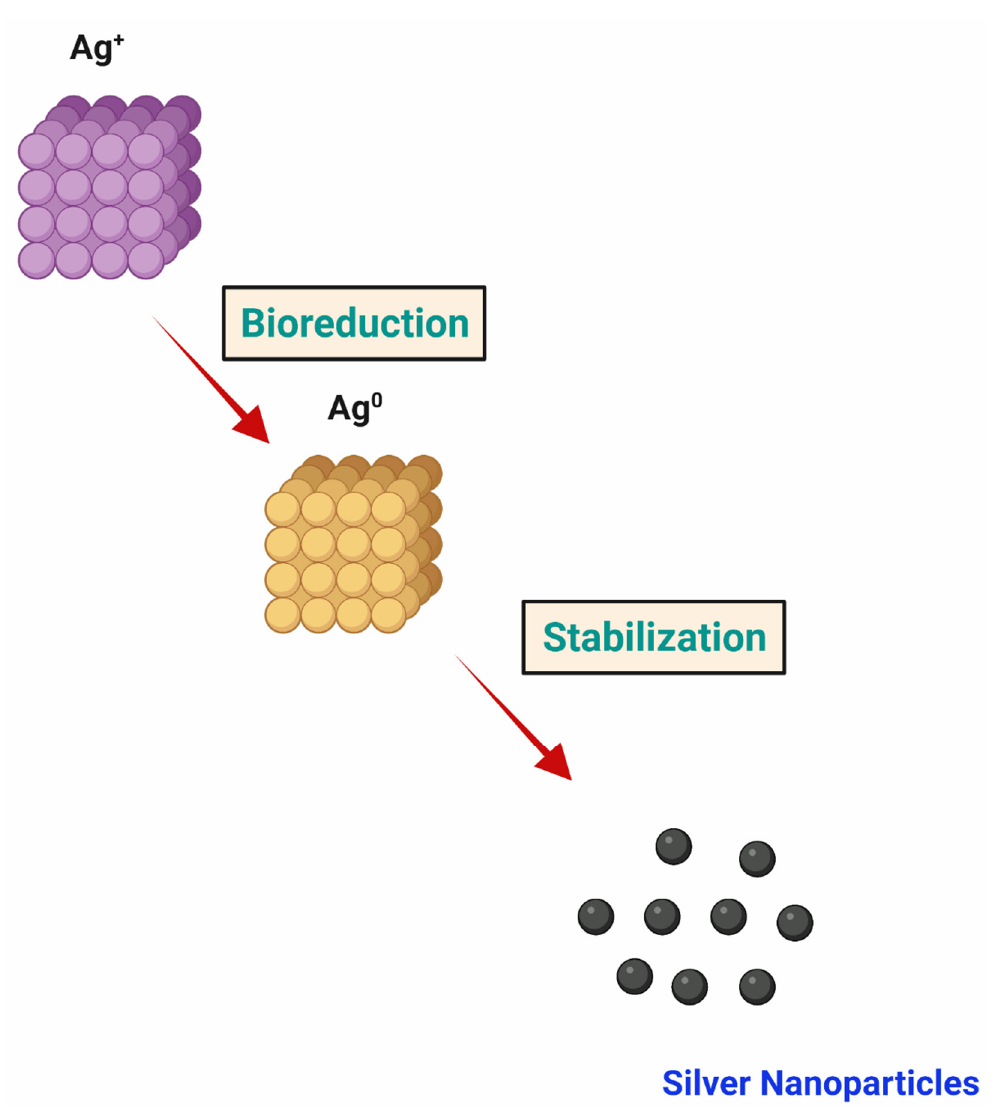
Figure 3. Green synthesis of silver nanoparticles from bioreduction of silver ions. The first step involves the bioreduction of positive Ag + into the zero-valent Ag 0 metal, while the last step involves the stabilization of metal NPs.